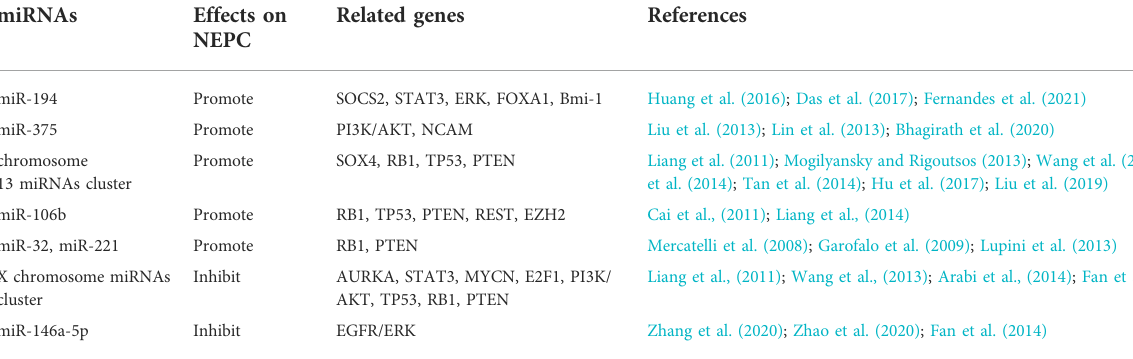
TABLE 2 Exosome-associated miRNAs and their functional relevance in